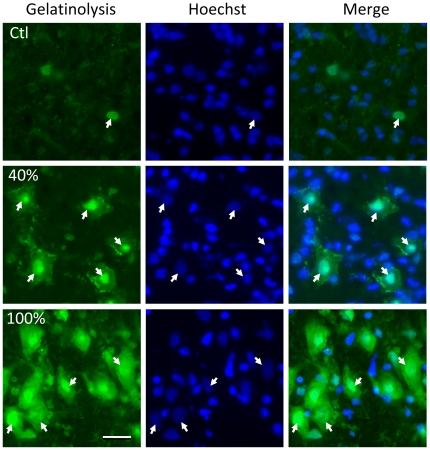

In situ zymography.Net gelatinase activity at the nuclear level. High power magnification of fluorescence photomicrographs of the striatum sections showing in situ zymography (green) and nuclear marker Hoechst (blue) in sham operated (Ctl) and after reoxygenation with 40% or 100% O2. Note that, the number of cells showing intense gelatinolysis in the nucleus (arrows) augments with the concentration of oxygen. Scale bar 25 µm.